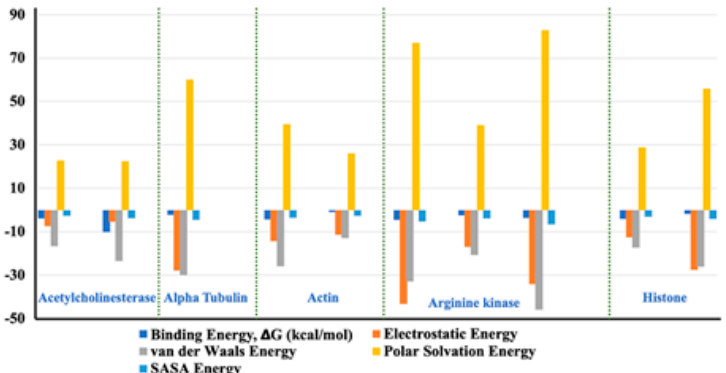
Figure 14. Representation of the van der Waals, electrostatic, polar solvation, SASA, and binding energy for docked compounds into: Acetylcholine esterase, Actin, Α -tubulin, Arginine kinase and histone subunit III with inhibitors (disodium 5 ′ -inosinate and petunidin 3-glucoside), (calcium 5 ′ - guanylate D and chlorogenic acid), chlorogenic acid, (kaempferol-3,7-di-o-glucoside I, hyperoside D, delphinidin 3-glucoside ID), and (myricetin 3 ′ -glucoside ID, hyperoside D) complexes.